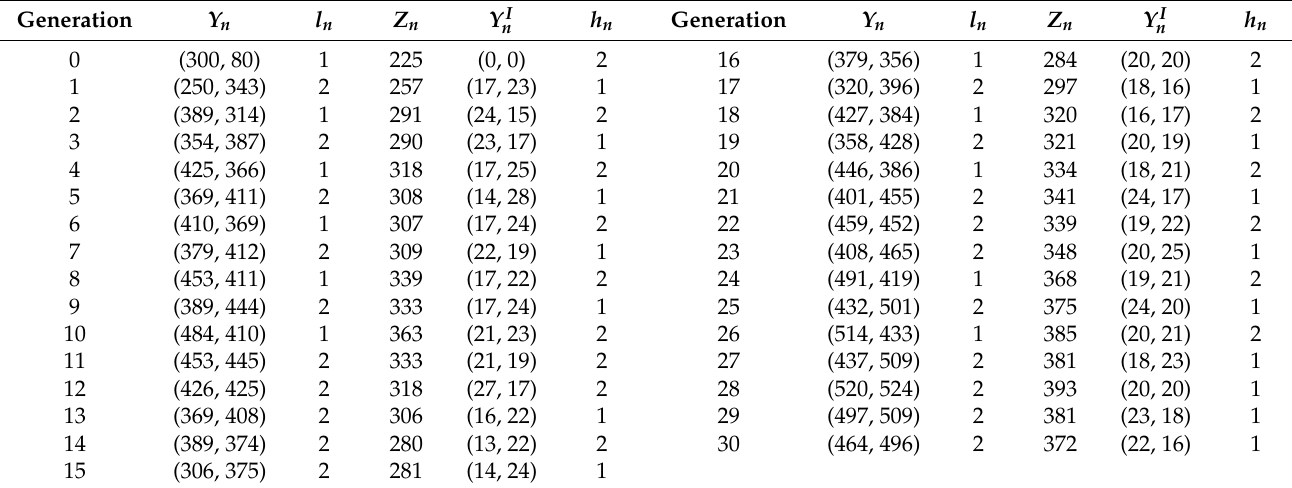
Table 2. Females and males ( Y n ), mating strategy ( l n ), couples ( Z n = L ϕ and males ( Y I n ) and reproductive strategy ( h n ) in the successive